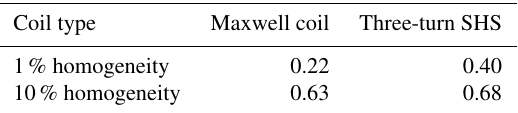
Table 1. Three-turn infinite plane coil homogeneity: comparison between the Maxwell and the three-turn SHS coils. The 1 and 10% homogeneity are defined as the fraction of the coil diameter where the magnetic field intensity remains, respectively, within 1 and 10% of its maximum value.